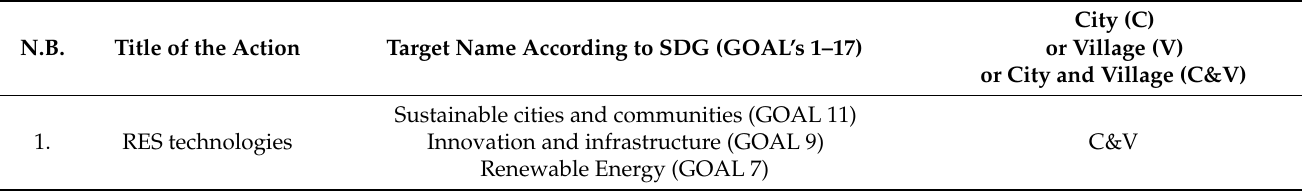
Table 7. EU solutions for decarbonization determinants from the SDG perspective (sustainable and low carbon cities)— implementation